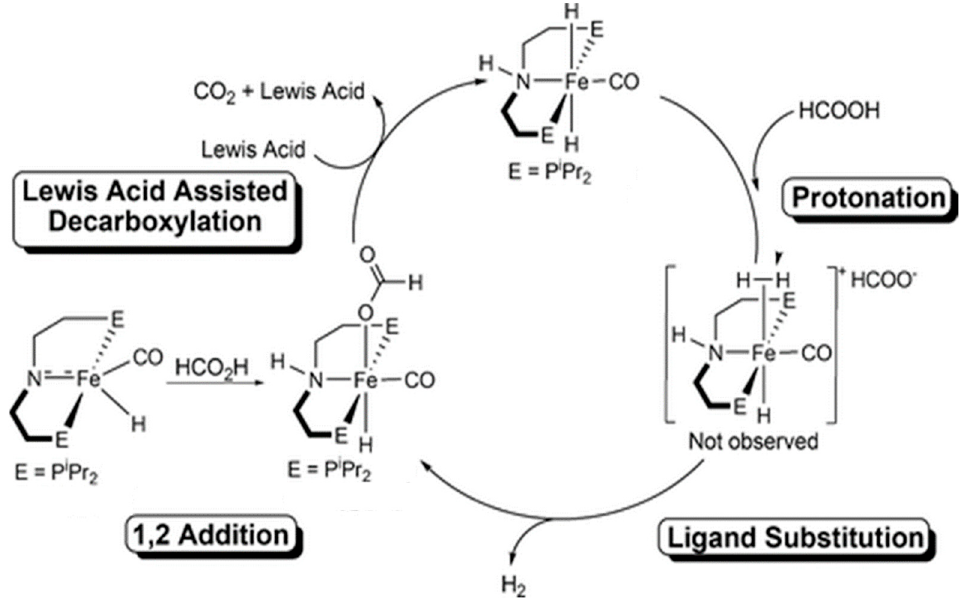
Figure 8. Proposed reaction mechanism for FADH catalyzed by Fe-4 in the presence of a Lewis acid [48] © ACS 2014. acid [48] © ACS